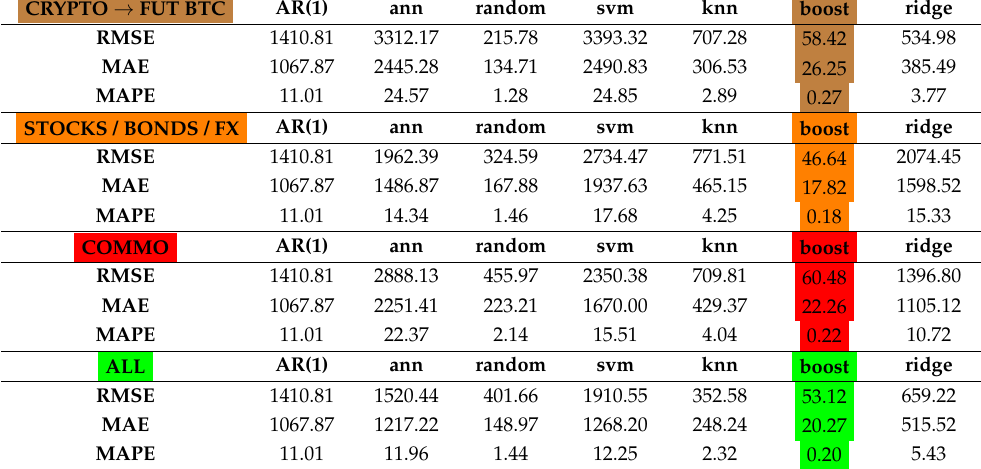
Note: AR(1) stands for the autoregressive model of order one; ann for the Artificial Neural Network model; random for the Random forest model; svm for the Support Vector Machine model; knn for the k-Nearest neighbor model; boost for the Adaboost model; and ridge for the Ridge regression. In terms of forecast statistics, we resort to the Root Mean Square Error (RMSE), the Mean Absolute Error (MAE), and the Mean Absolute Percent Error (MAPE). Table 13. Sub-sample forecasting results of CME Bitcoin Futures price during the year